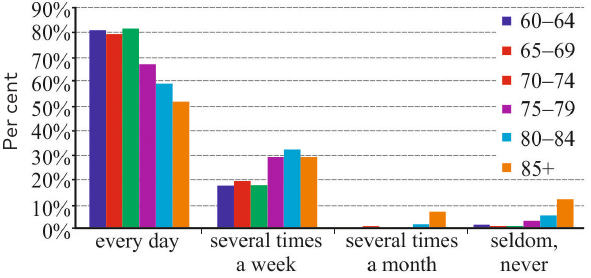
Figure 2. The frequency of leaving home by age group, Austria (Daniel, Pokriefke, & Risser,